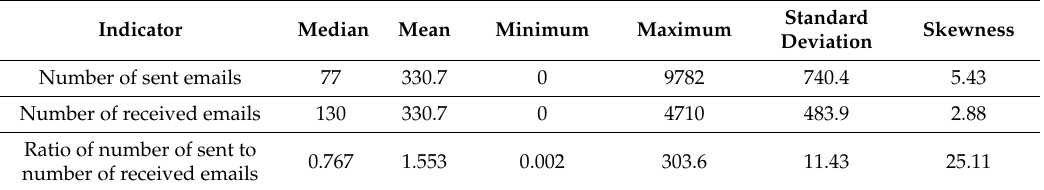
Table 2. Basic email activity indicators, individual level.